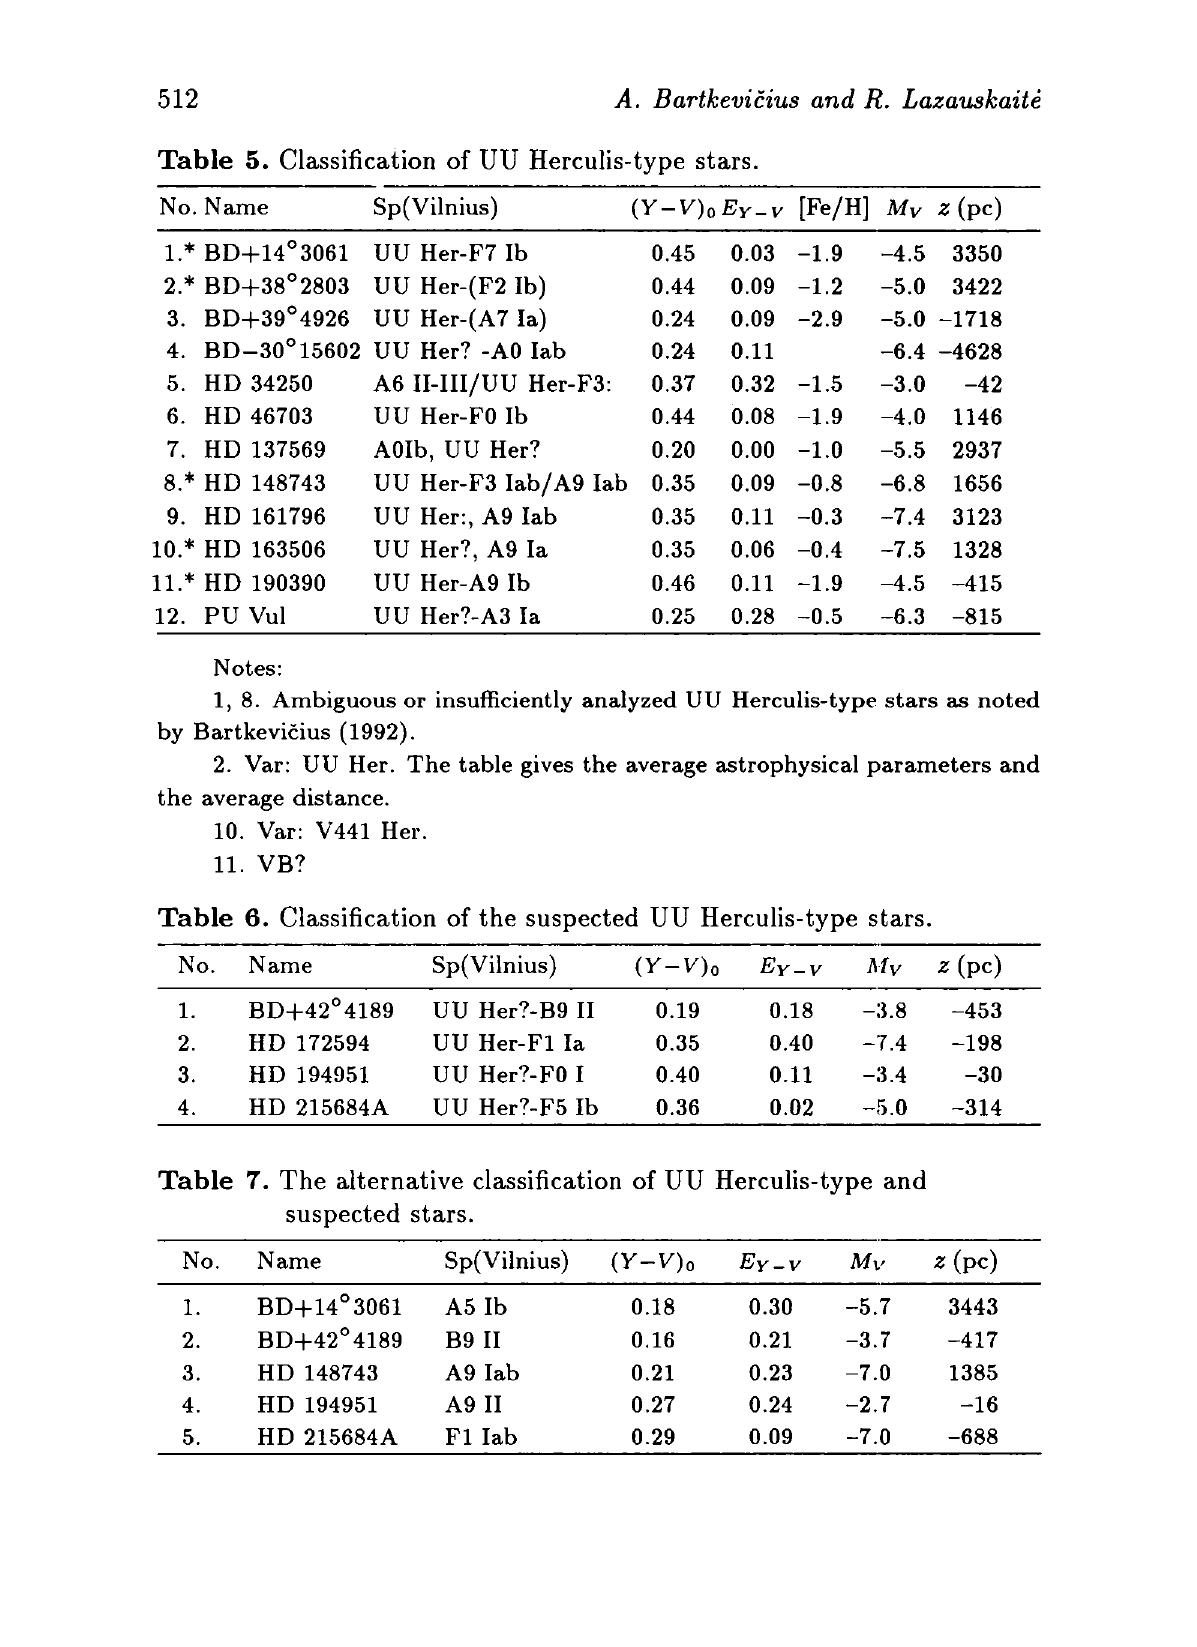
Table 7. The alternative classification of UU Herculis-type and suspected